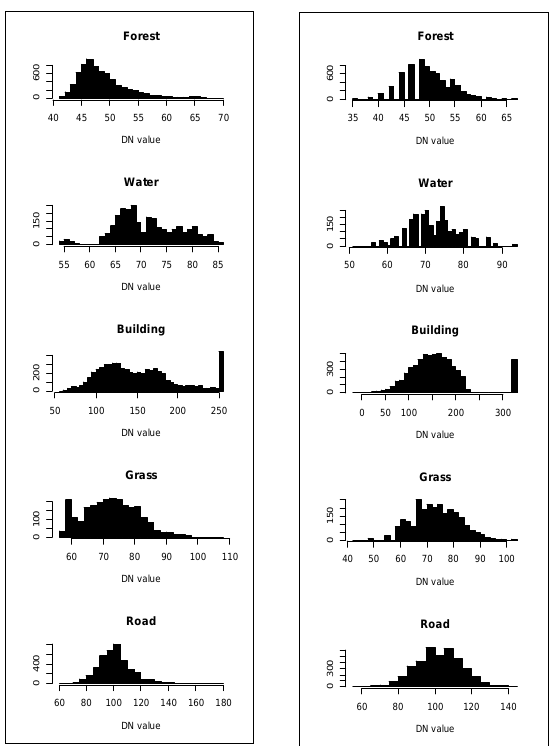
Figure 2. Histograms of Red band of original data(left) and transformed data(right) in the five classes: Forest, Water, Building, Grass and